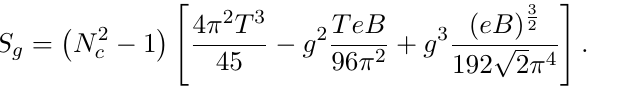
In addition to the temperature, the explicit dependence of the magnetic (cid:12)eld can be found out by substituting the Debye mass for the two massless (cid:13)avors from eq. (3.38) into the above